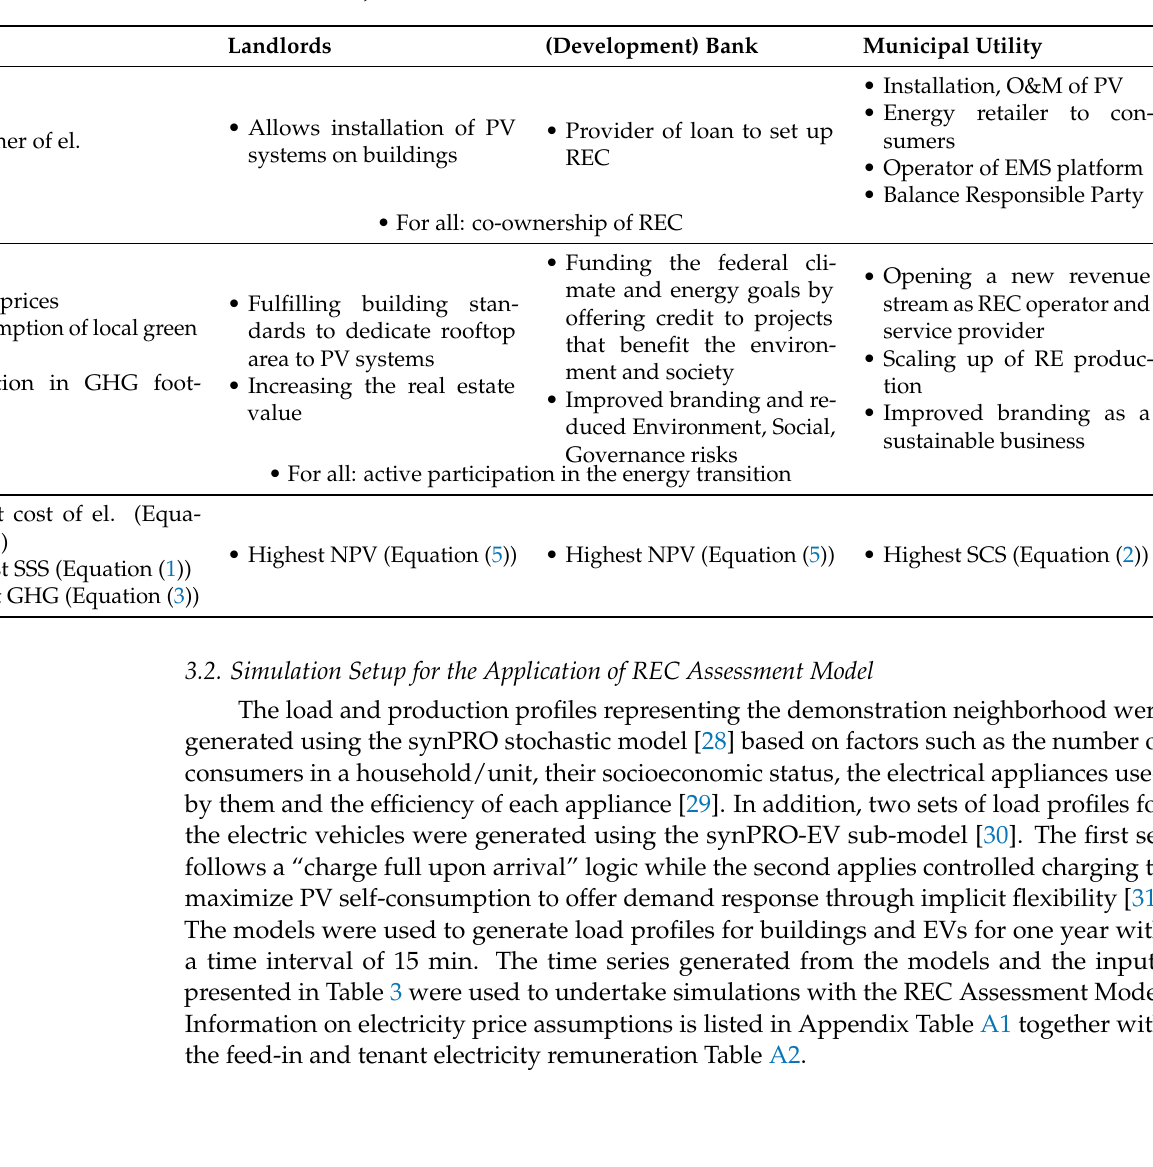
Table 2. Roles, Objectives and KPIs for Actors of REC